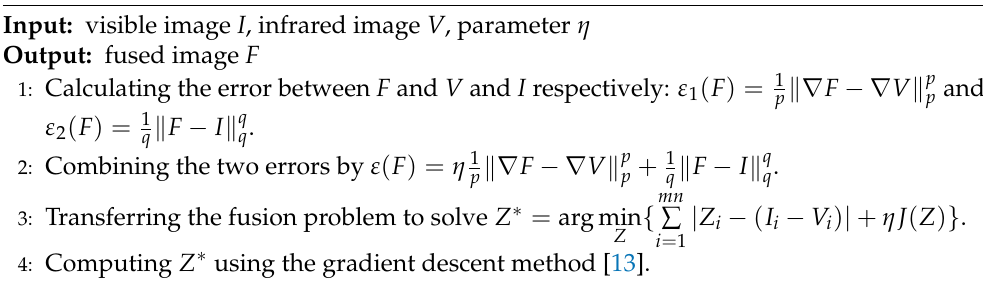
Algorithm 1 Visible and infrared image fusion